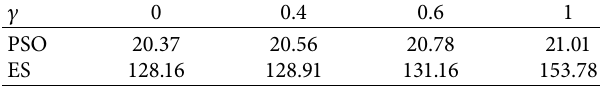
Table 3: Running time (in seconds) of the PSO and ES algorithms.